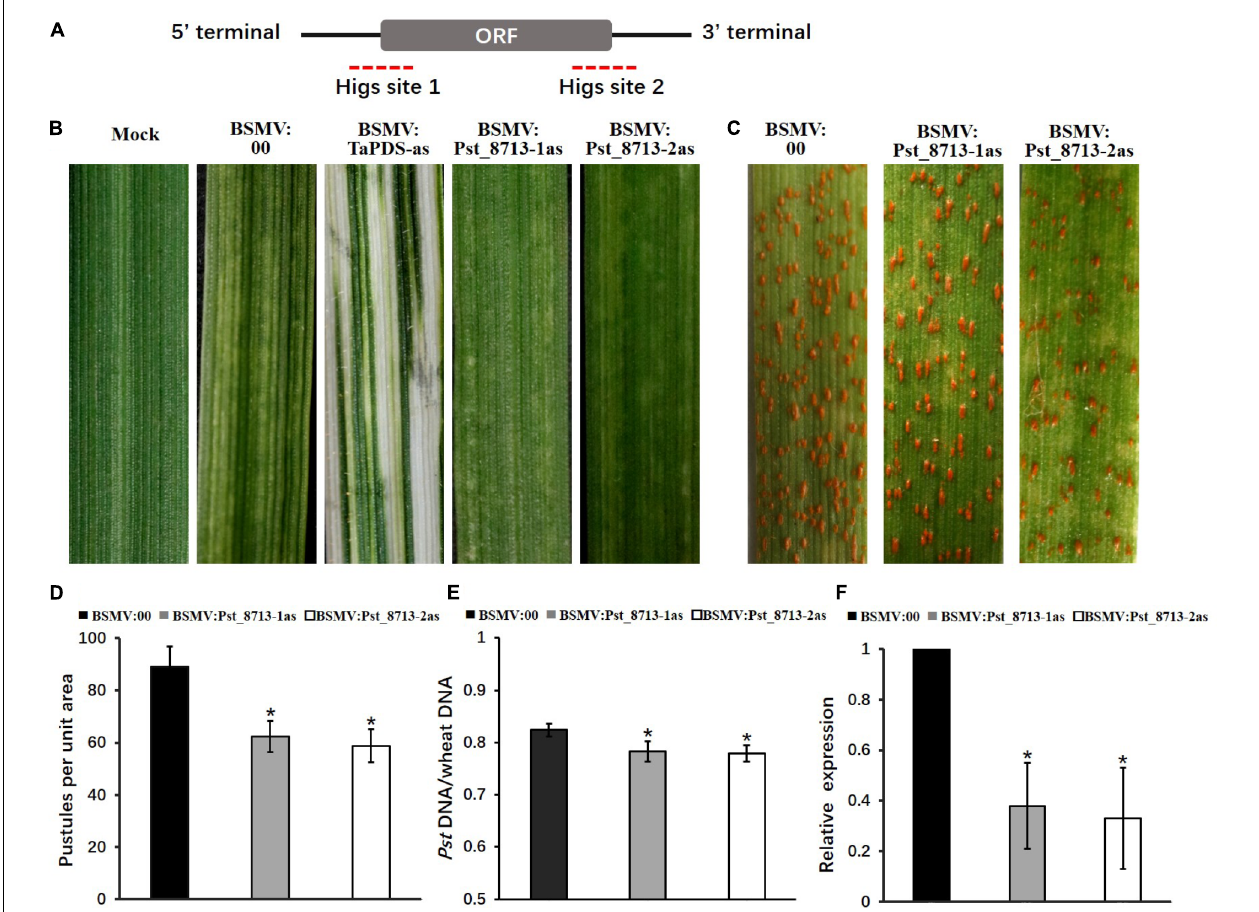
FIGURE 8 | BSMV-mediated HIGS of Pst_8713 decreased susceptibility of wheat plants to Puccinia striiformis f. sp. tritici ( Pst ). (A) Pst_8713 transcript with CDS and 5 (cid:48) and 3 (cid:48) UTRs. The dotted parts are two specific sequence regions for HIGS. (B) Phenotypes of the fourth leaves of wheat plants after inoculation with FES buffer (mock), BSMV:00 (control), BSMV:TaPDS, BSMV:Pst_8713-1as, and BSMV:Pst_8713-2as. (C) Phenotypes of the wheat leaves pre-inoculated with BSMV:00 (control), BSMV:Pst_8713-1as, and BSMV:Pst_8713-2as and then inoculated with Pst virulent isolate CYR32. (D) Quantification of Pst uredinia formation. The means and standard errors were from three biological replicates, and for each replicate, at least six treated leaves were used for uredinia accumulation. (E) Fungal biomass measurements using qRT-PCR analysis of total genomic DNA extracted from control (BSMV:00-inoculated) and Pst_8713 -silenced wheat plants. Ratio of total Pst genomic DNA to total wheat genomic DNA was assessed using the Pst gene PsEF1 and the wheat gene TaEF1 . The means and standard errors were from three biological replicates. (F) The relative expression of Pst_8713 after knocking down. The expression values are relative to the Pst endogenous gene EF1 , with